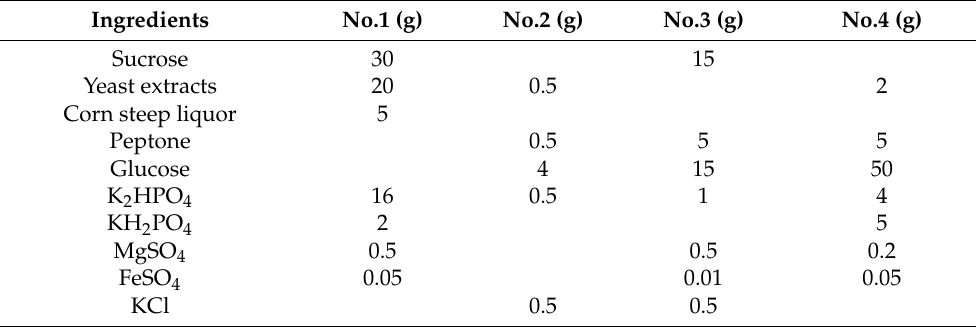
Table 3. Four different biotransformation media